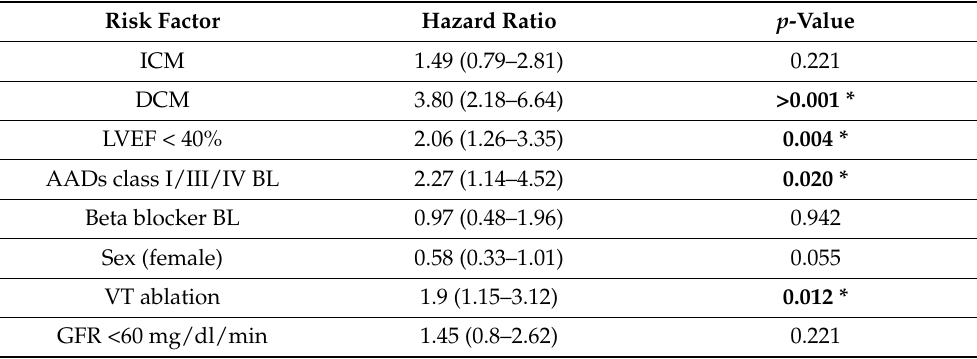
Table 3. Multivariate Cox regression analysis of risk factors for VA recurrence of patients undergoing RMN ablation.